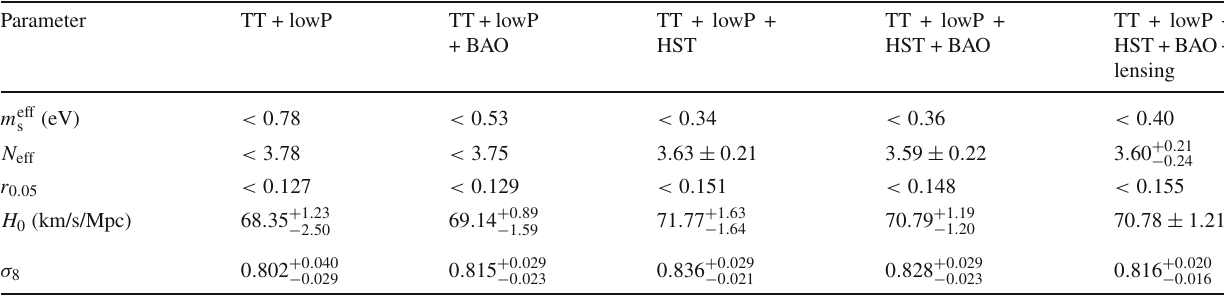
Table 2 Bounds on cosmological parameters in the (cid:2) CDM + r 0 . 05 + N eff + m eff s model without BK14 data. Marginalized limits are given at 68% C.L. whereas upper limits are given at 95% C.L.. Note that H 0 and σ 8 are derived parameters